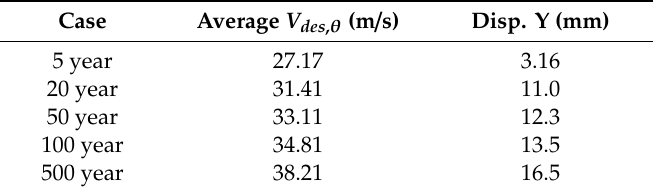
Table 5. Impact of wind load on deflection of prestressed cabling.